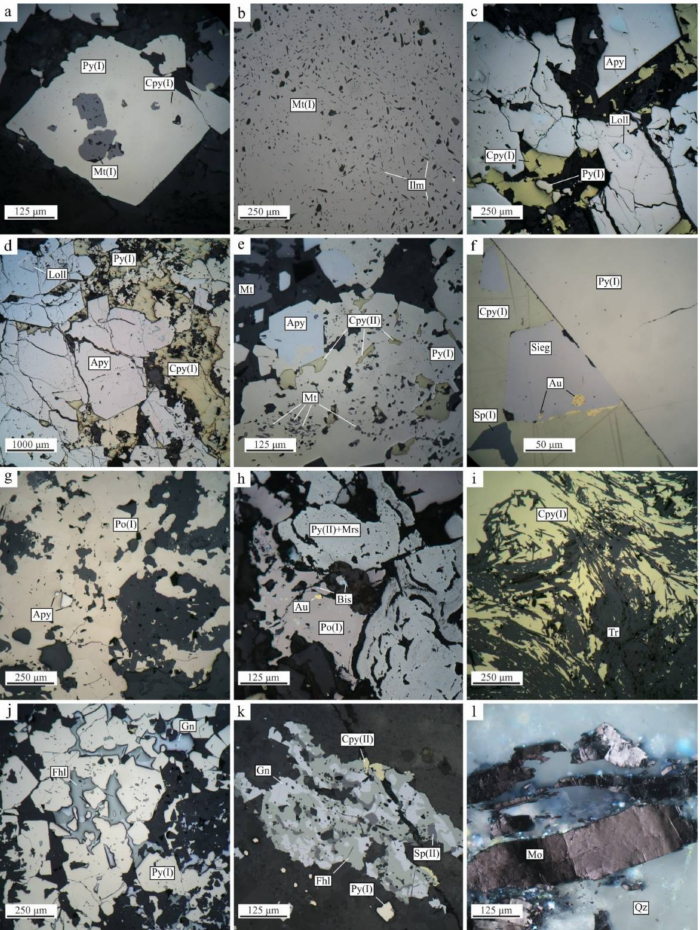
Figure 10. Photomicrographs of polished sections showing relationships of ore minerals at the Kul- tuma deposit. ( a ) pyrite replacing magnetite; ( b ) ilmenite exsolution lamellae in titanomagnetite; ( c ) microinclusion of lollingite in arsenopyrite; ( d ) crashed euhedral grains of the arsenopyrite and pyrite cemented by a chalcopyrite aggregate; ( e ) magnetite and chalcopyrite microinclusions in pyrite; ( f ) early pyrite forms intergrowths with siegenite; native gold is developed on the edges of the siegen- ite euhedral grains; ( g ) massive pyrrhotite aggregate with arsenopyrite; ( h ) replacement of pyrrhotite by a marcasite–pyrite aggregate (“bird eyes” structure); ( i ) massive chalcopyrite xenomorphic aggre- gate in retrograde tremolite skarn; ( j ) galena and tetrahedrite cementing crashed grains of the pyrite; ( k ) myrmekitic-like intergrowth of tetrahedrite, galena, sphalerite, chalcopyrite; ( l ) deformed molyb- denite platelets in quartz. Abbreviations: Tr—tremolite; Qz—quartz; Mt—magnetite; Ilm—ilmenite; Cpy—chalcopyrite; Apy—arsenopyrite; Loll—lollingite; Py—pyrite; Sieg—siegenite; Po—pyrrhotite; Mrs—marcasite; Gn—galena; Mo—molybdenite; Fhl—fahlore; Sp—sphalerite; Bis—bismuthinite; Au—native gold; ( a – k ) Nic. //; ( l )—Nic.